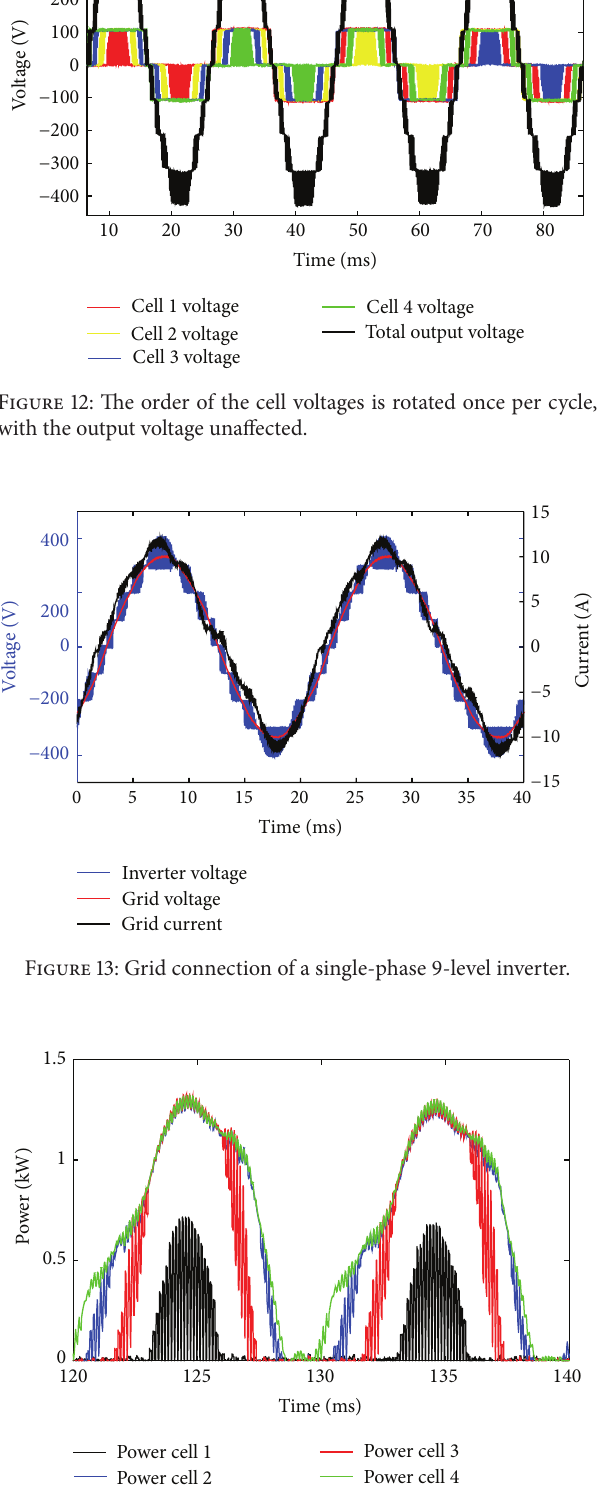
Figure 14: Power output from each cell during one fundamental cycle of grid connection. The power is divided between the cells into 4.3%, 33.6%, 25.5%, and 36.6%, respectively.